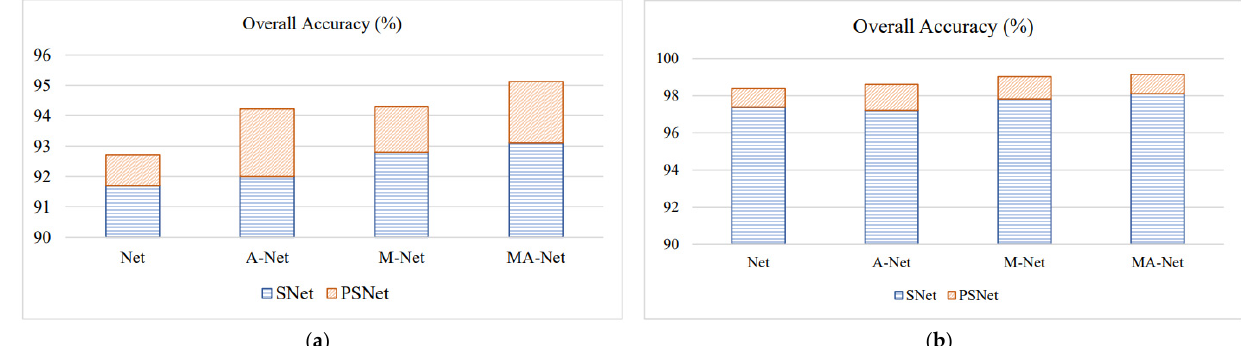
Figure 10. Comparison of classification accuracy between two datasets using Siamese Network and Pseudo-Siamese Network ( a ) Houston dataset. ( b ) Trento dataset. Pseudo-Siamese Network ( a ) Houston dataset. ( b ) Trento dataset.